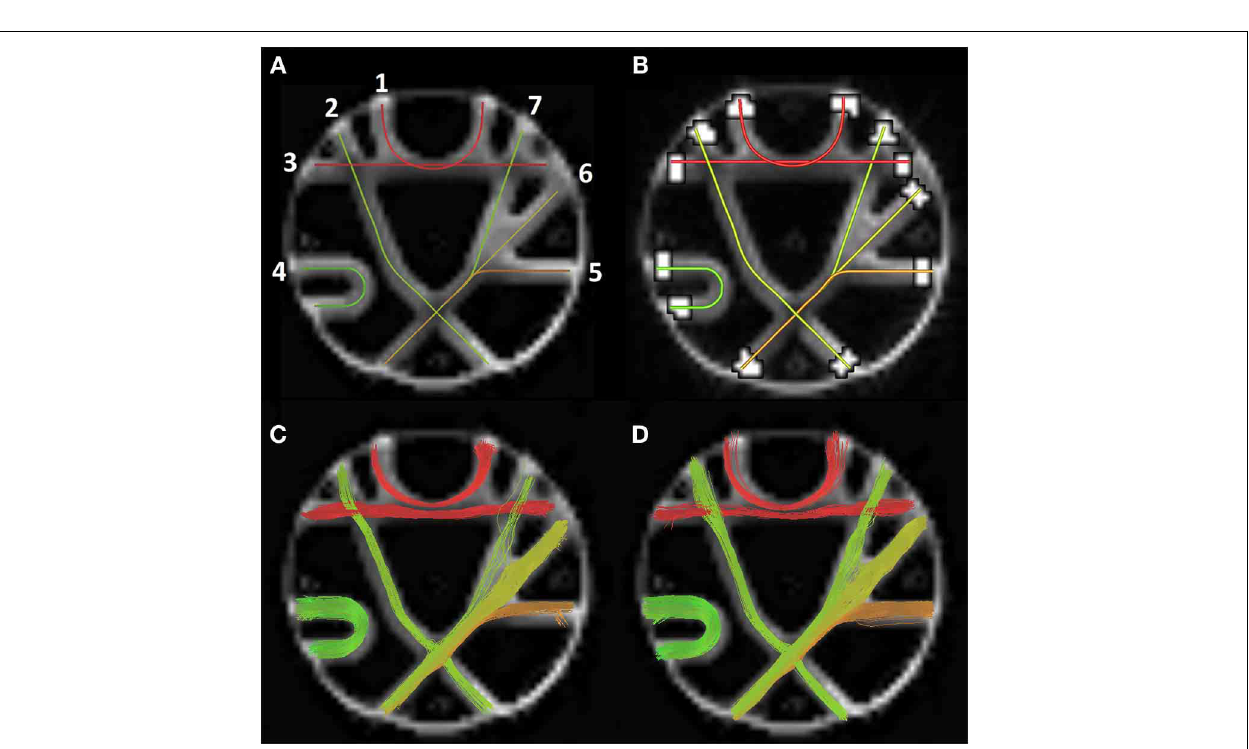
Bottom row reveals the bending part of the Cg, a part that is often missing when performing DTI-based tractography. (HC dataset).